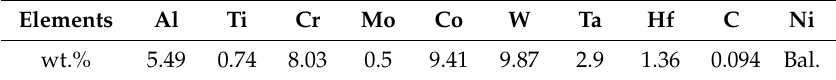
Table 2. Variation in eccentric distance of the selector part.